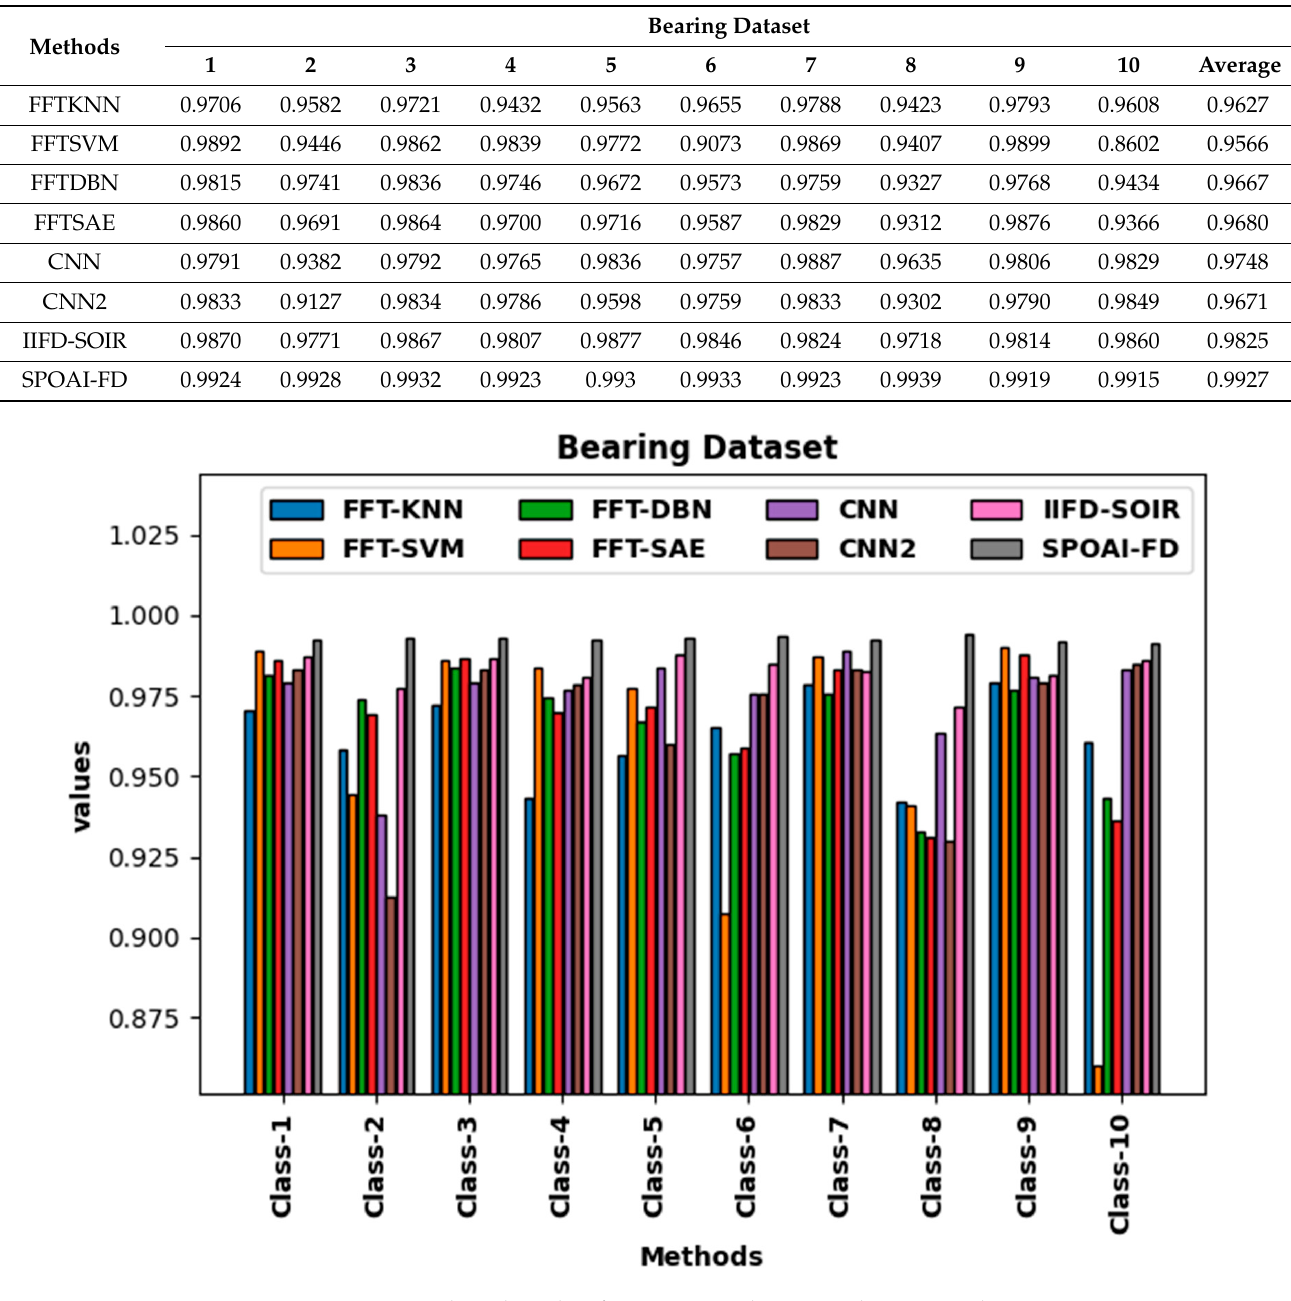
Figure 7. Analytical results of SPOAI-FD technique under Bearing dataset. Table 6 provides the overall average analysis results of the SPOAI-FD and other recent methodologies. Figure 10 offers the comparative average accuracy analysis outcomes of SPOAI-FD approach and other methods on gearbox dataset. The results show that the SPOAI-FD technique outperformed all other methods with maximum training and testing